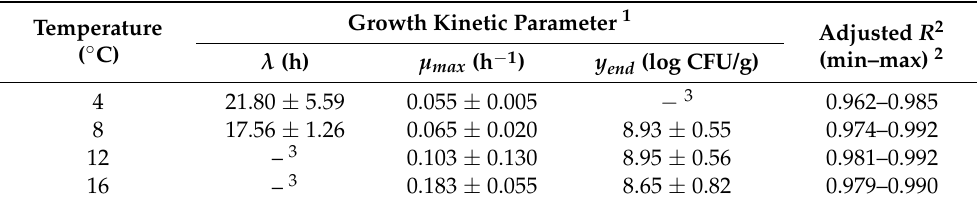
Table 1. Growth kinetic parameters of Listeria monocytogenes in artificially inoculated battered chicken nuggets stored at different